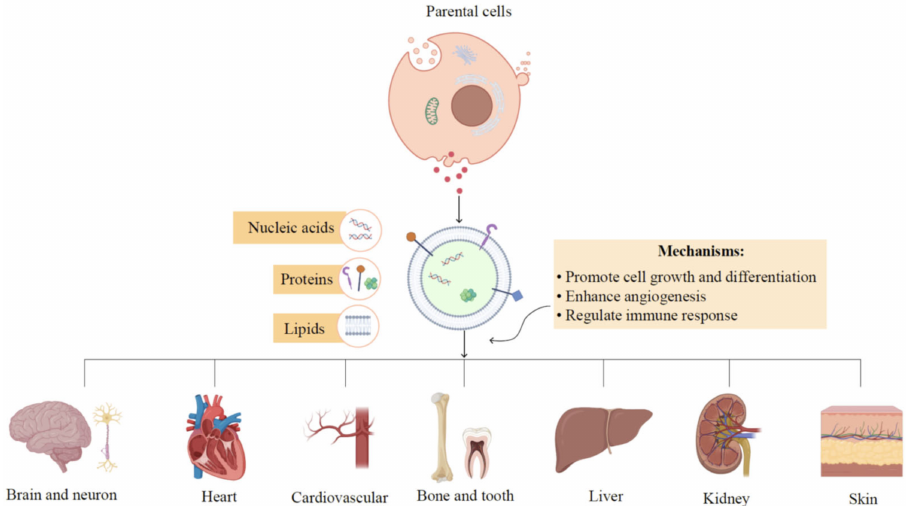
Figure 3. Therapeutic mechanisms of EVs in tissue regeneration. EVs derived from various parent cells contain nucleic acids, proteins, and lipids, which exhibit their functions in tissue regeneration. The regenerative potential of EVs is mainly attributed to their direct impacts on target cells in the regulation of cell apoptosis, proliferation, and differentiation, as well as their indirect effects on enhancing angiogenesis and modulating immune